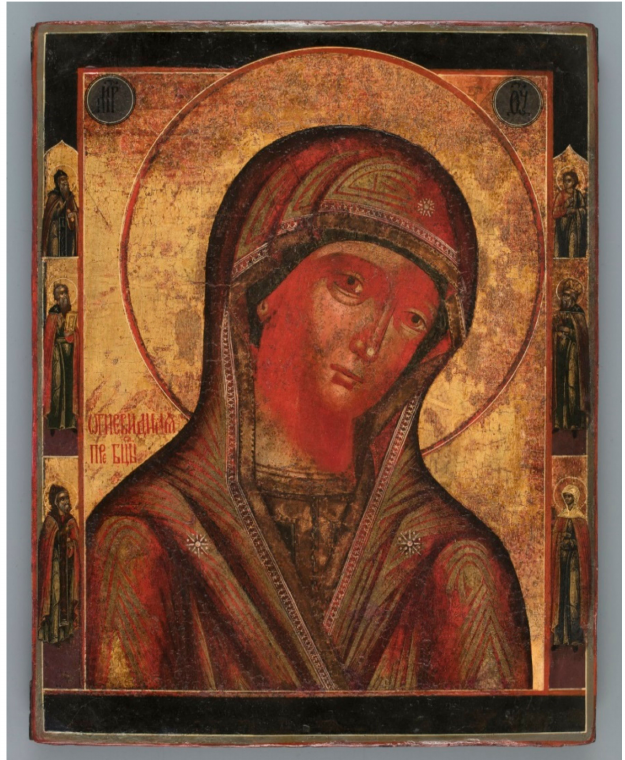
Figure 9. Mother of God Looks like Fire ( Ognevidnaya ), Belarus, Vetka, workskop of priest Old Believers, beginning of 19th c., tempera on wood, 35.5 × 27.6 cm, National Museum in Warsaw, photo: Piotr Ligier.